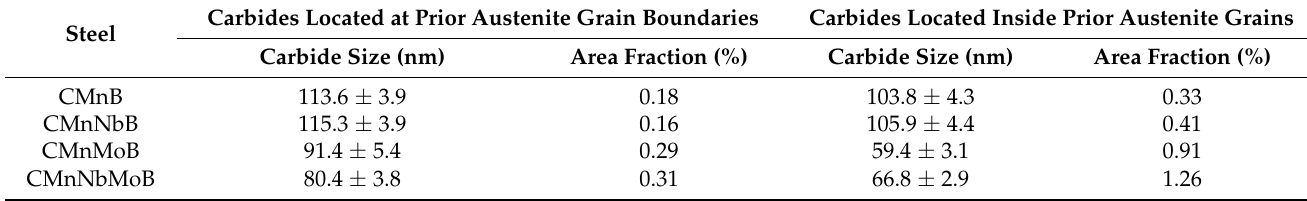
Figure 2. Optical micrographs after quenching (Q state) corresponding to ( a ) CMnB, ( b ) CMnNbB, ( c ) CMnMoB, and ( d ) CMnNnMoB steels. Table 2. Measured mean carbide sizes and carbide densities considering both type of carbides (carbides located at prior austenite grain boundaries and inside prior austenite grains).